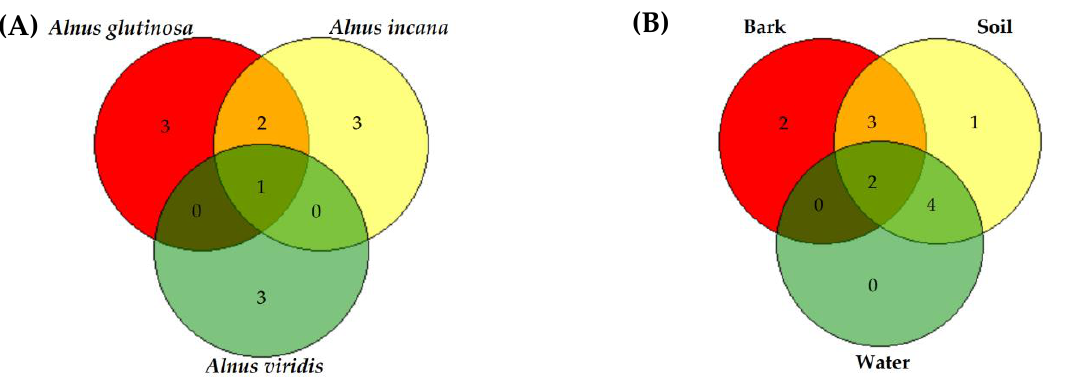
Figure 2. Venn diagrams illustrating the number of unique and shared Phytophthora species among alder species ( A ) and substrates used for isolations ( B ).